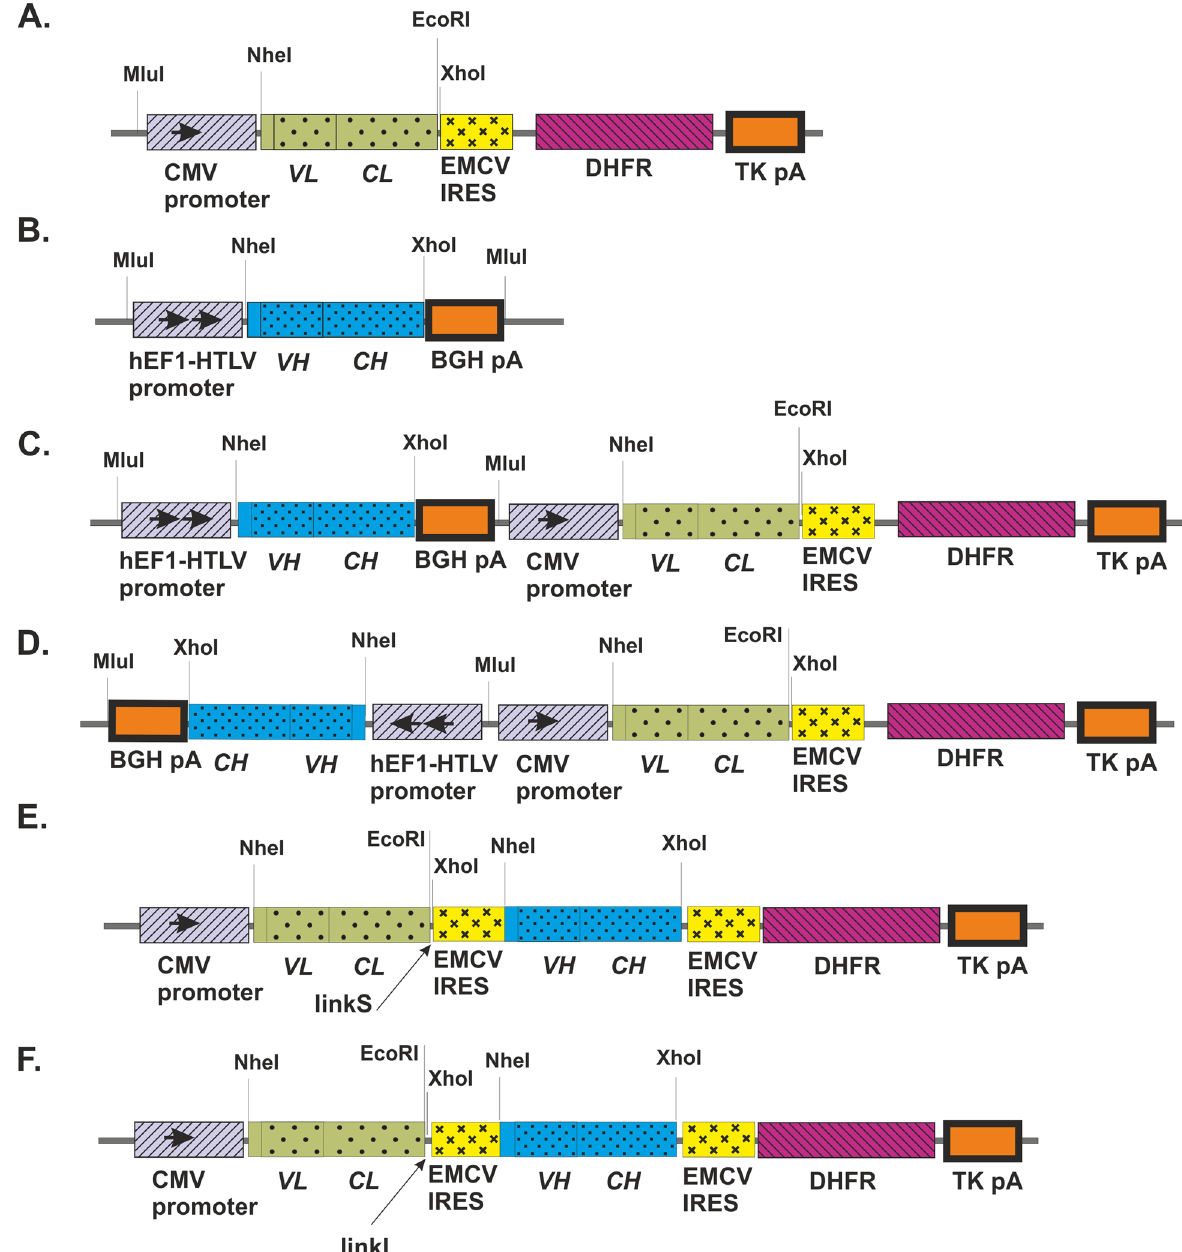
Fig. 1 Schematic representation of the plasmid vectors pOpti-L-MluI ( A ), pSK-EF1-H-BGH ( B ), pBiPr-HL–ht ( C ), pBiPr-HL–hh ( D ), pOpti-L-IRES(Short)-H ( E ), and pOpti-L-IRES(Long)-H ( F ). VH and VL, variable domain coding sequences of HC and LC of the mAb with own Kozak sequences and leader peptides, respectively; CH and CL, constant domain coding sequences of the HC and LC of the mAb, respectively; EMCV IRES, IRES from the encephalomyocarditis virus (EMCV) for cap-independent translation of DHFR and HC of the mAb; TKpA, the Herpes Simplex Virus thymidine kinase polyadenylation signal for proper termination and processing of the recombinant transcript; hEF1-HTLV promoter, hybrid composite promoter comprising the Elongation Factor-1α (EF-1α) core promoter1 and the R segment and part of the U5 sequence (R-U5 ′ ) of the Human T-Cell Leukemia Virus (HTLV) Type 1 Long Terminal Repeat2; LinkS, short variant EMCV IRES (distance 54 b.p. between TGA LC and EMCV IRES beginning); LinkL, long variant EMCV IRES (88